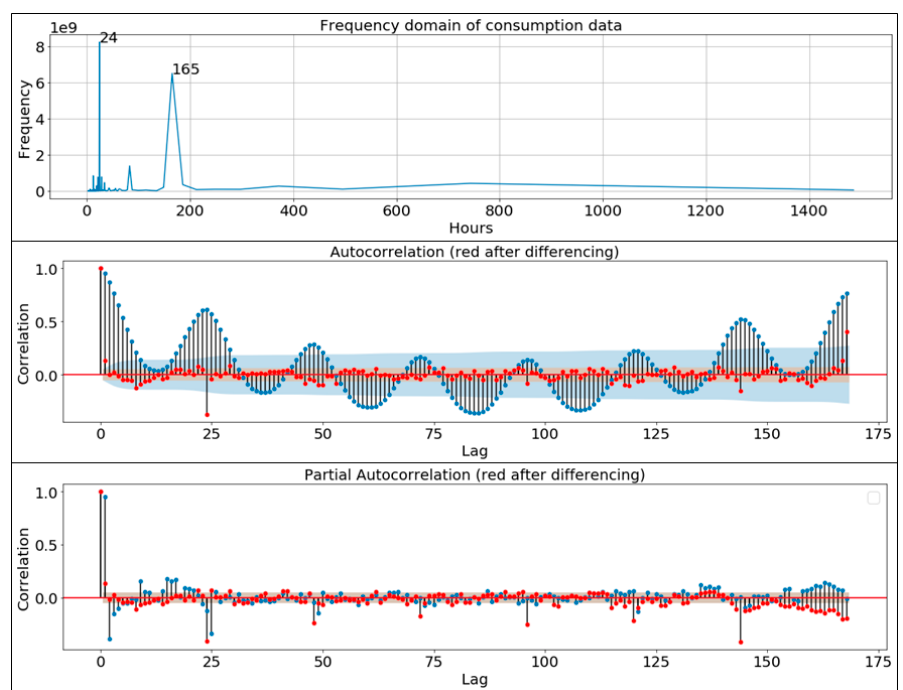
Figure 5. Frequency domain of consumption data by Fourier transformation with autocorrelation function (ACF) and partial autocorrelation functions (PACF) functions. The correlation outside the standard deviations are correlations and not a statistical fluke. The red color represents the ACF and PACF after differencing the time series.